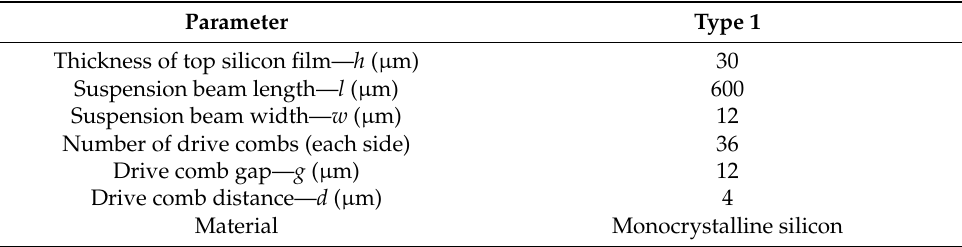
Table 1. Main parameters of Type 1 MEMS resonator. Parameter Type 1 Thickness of top silicon film— h ( µ m) 30 Suspension beam length— l ( µ m) 600 Suspension beam width— w ( µ m) 12 Number of drive combs (each side) 36 Drive comb gap— g ( µ m) 12 Drive comb distance— d ( µ m) 4 Material Monocrystalline